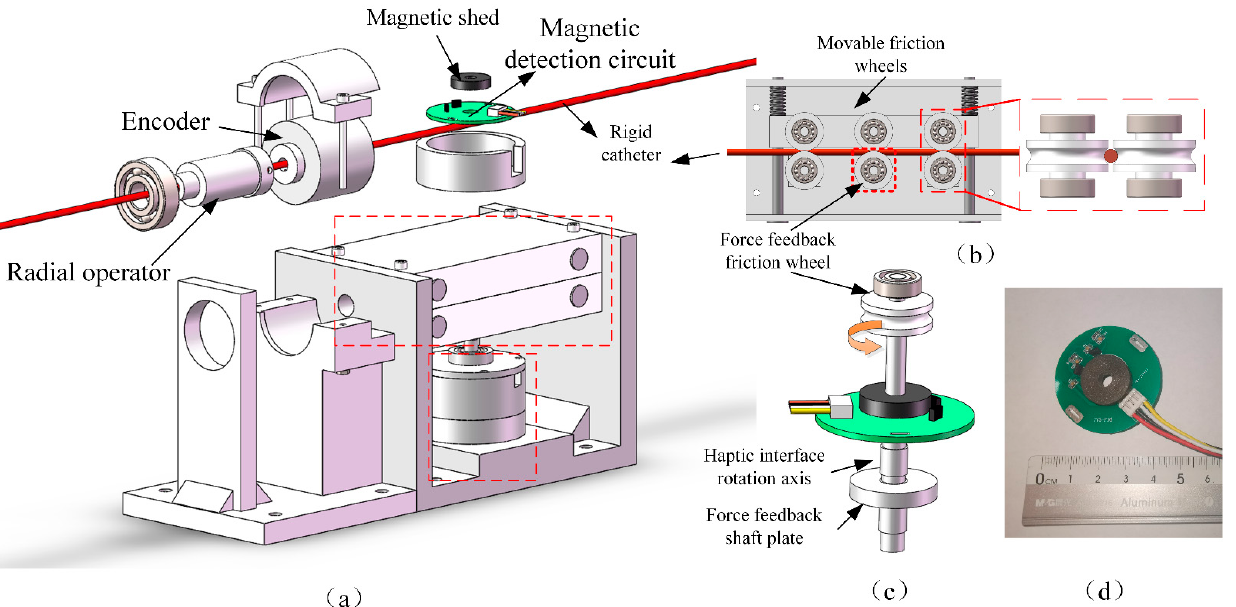
Figure 4. Exploded view of developed master manipulator. ( a ) Master manipulator. ( b ) Structure of axial delivery unit. ( c ) Haptic feedback interface. ( d ) Hall Encoder.